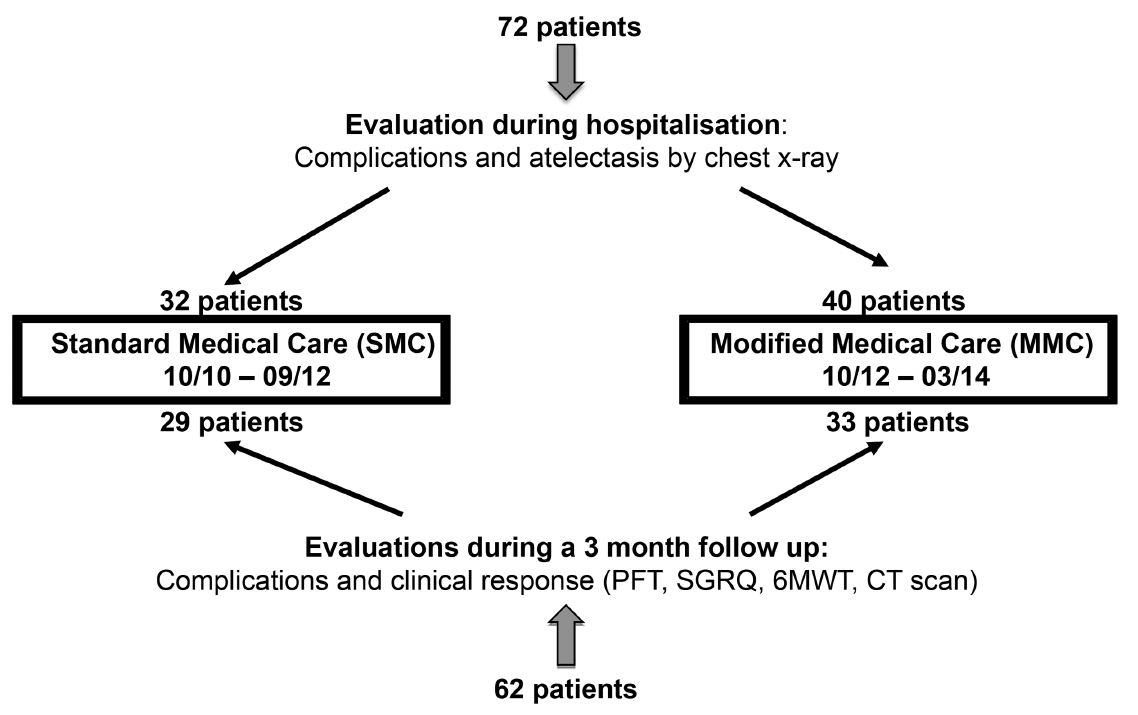
Fig 1. Study design. Seventy-two CV negative patients were treated with endobronchial valves at Charité Hospital between 2010 and 2014. In a retrospective study design, complications and development of an atelectasis were evaluated during hospitalization in all 72 patients comprising 32 patients with Standard Medical Care (SMC) (without restriction to bed rest) and 40 patients with Modified Medical Care (MMC) including strict 48 hour bed rest and cough suppression. Complication rate and clinical outcomes comprising pulmonary function, 6MWT and SGRQ during a three month follow up were assessed in 62 out of the 72 valve treated patients. CT scans at 3 months were available for 26 patients in the SMC and 29 patients in the MMC-cohort. CV: collateral ventilation. PFT: pulmonary function test. SGRQ: St. George respiratory questionnaire, TLVR: target lobe volume reduction, 6MWT: six minute walk